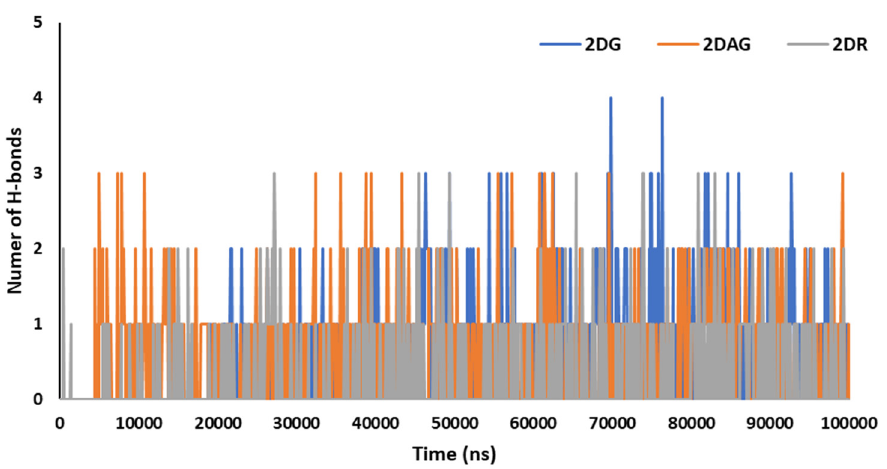
Figure 7. Trajectory of hydrogen bonds for the main protease of SARS-CoV-2 with 2-deoxy-D-ribose (2DR), 2-deoxy-glucose (2DAG) and 2-deoxy-D-glucose (2DG).